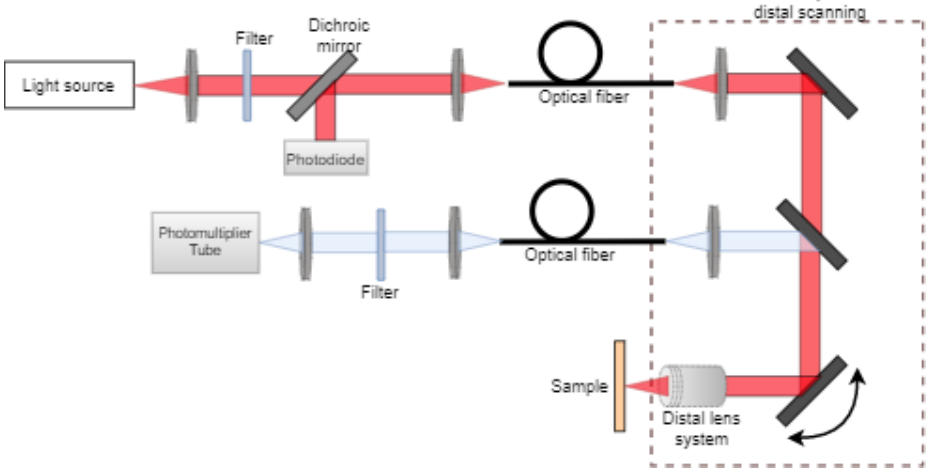
Figure 5. Schematic diagram of a nonlinear endoscope.